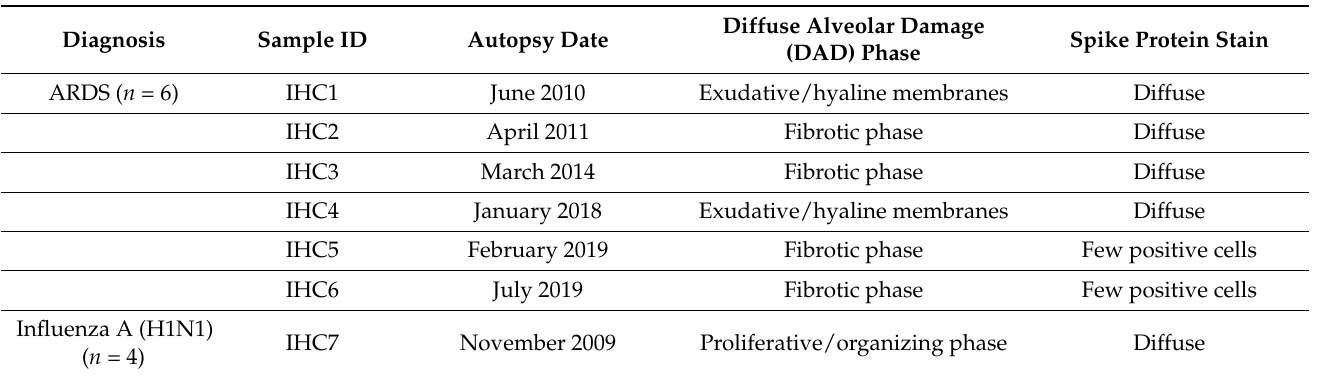
Table 2. List of lung autopsy cohort for testing IHC staining of SARS-CoV-2 spike glycoprotein.